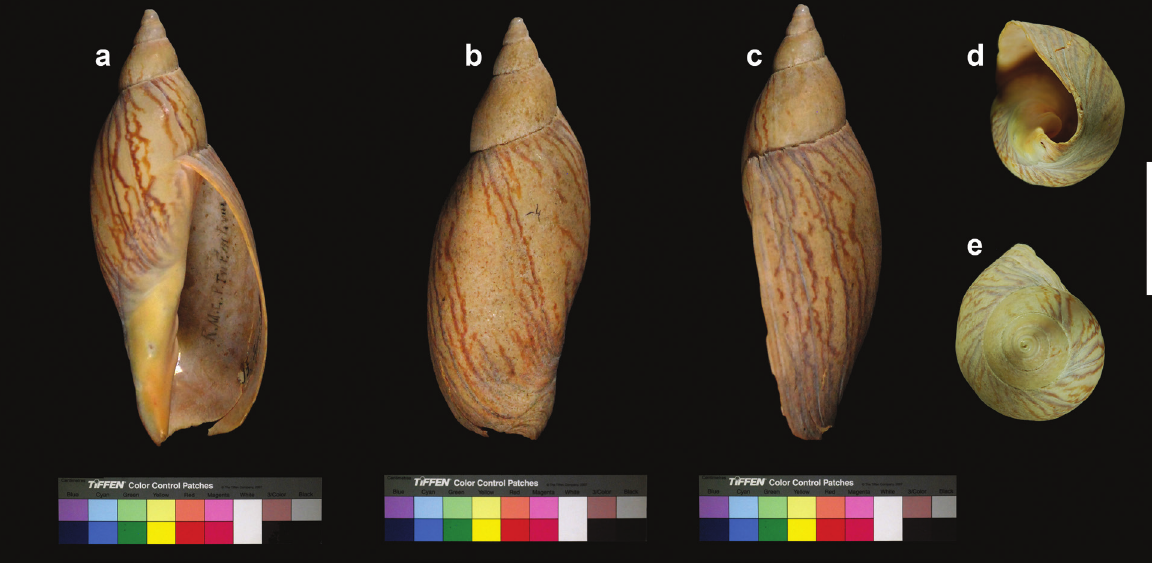
Figure 6. Voluta ancilla typica , specimen figured by Lahille (1895: pl. VIII, fig. 192) a Apertural view b Dorsal view c Lateral view d Umbilical view e Apical view. Scale bar: 5